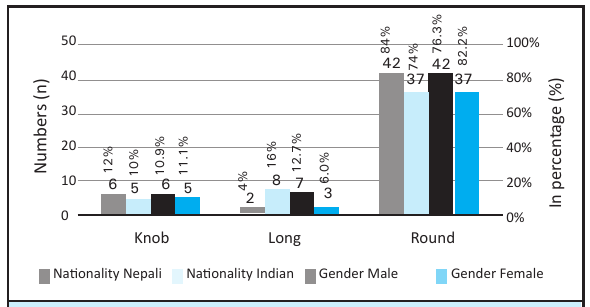
Figure 2. Variation of shape of tragus according to the nationality and gender (n=100).